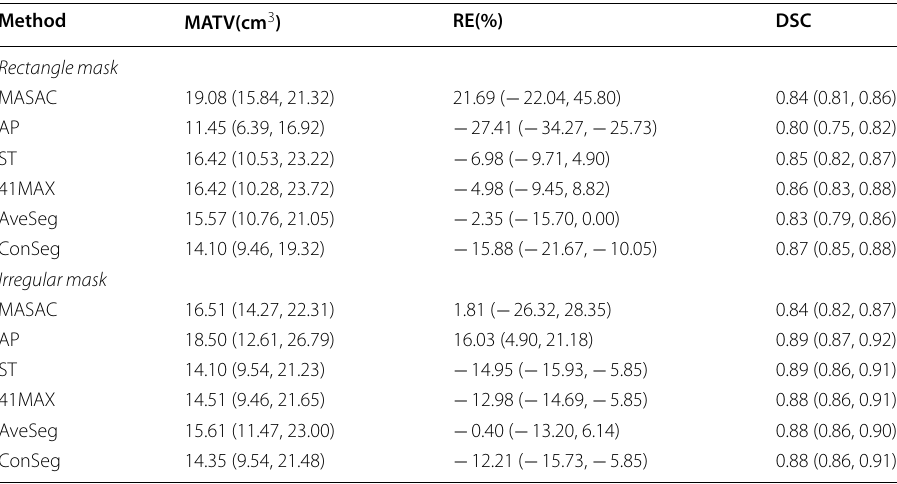
Table 4 Quantitative metrics used for assessment of the four individual segmentation methods, the average of four segmentation results (AveSeg) and the consensus method (ConSeg) for the simulated phantom studies without respiratory